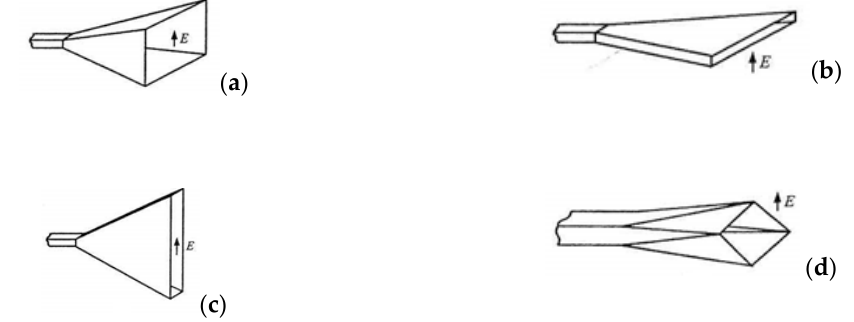
Figure 9. Types of needle-cone antenna shapes. ( a ) pyramid; ( b ) flat E; ( c ) flat H; ( d ) diagonal cone [23].